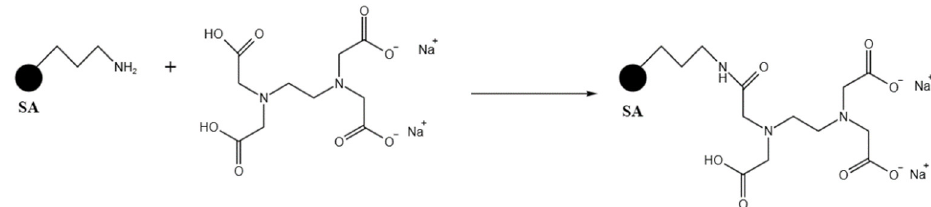
Figure 1. Schematic reaction of SA-NH 2 with EDTA-2Na.